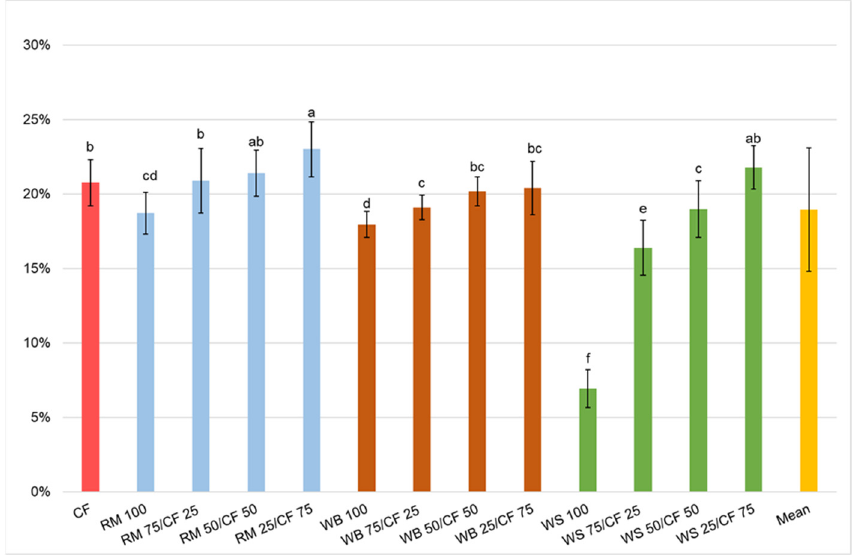
Figure 5. Mealworm efficiency of ingested feed (ECI) conversion. a,b,c…—letters indicate that values are statistically different (Tukey’s test at p < 0.05).